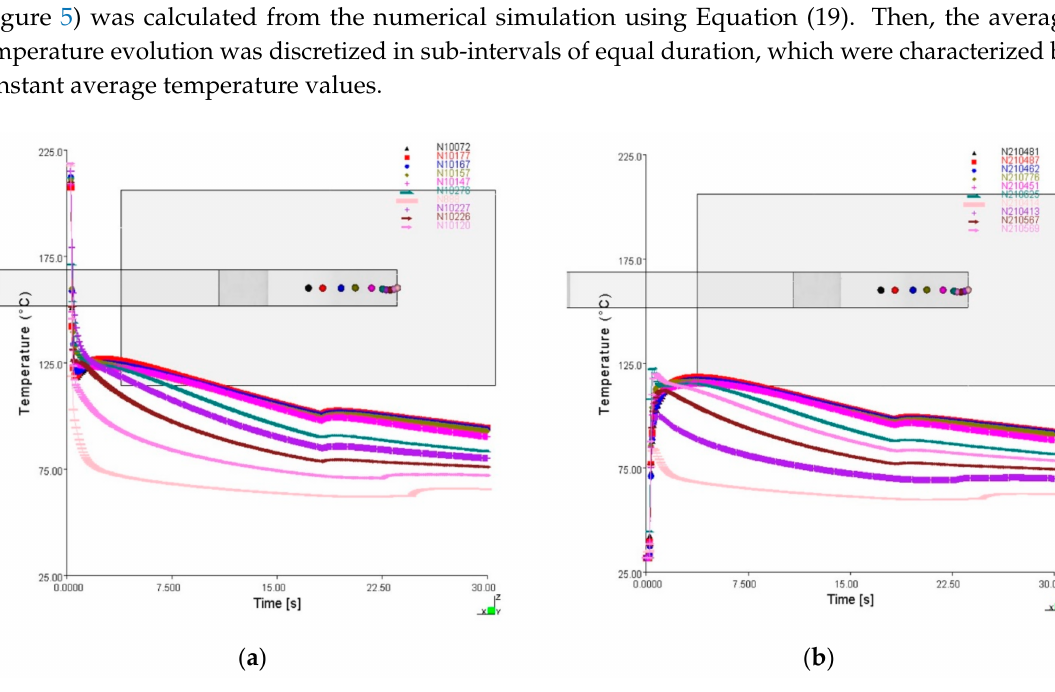
Figure 5. Interface temperature evolution of ( a ) the overmolded stem and ( b ) the base, as numerically calculated with both T melt and T base initially at the low